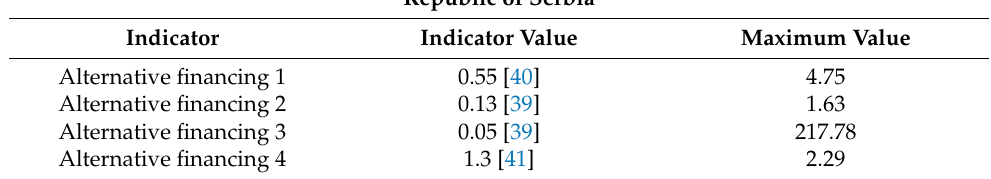
Table 9. The components of finance in the digital dimension—the startup phase of an enterprise (the table refers to the Republic of Serbia and was made in the likeness of the EIDES report).